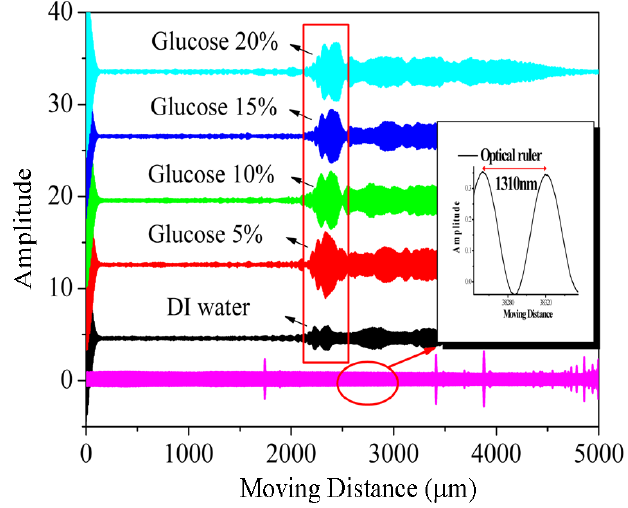
Figure 7. The interferograms from various glucose concentrations in TE polarization.